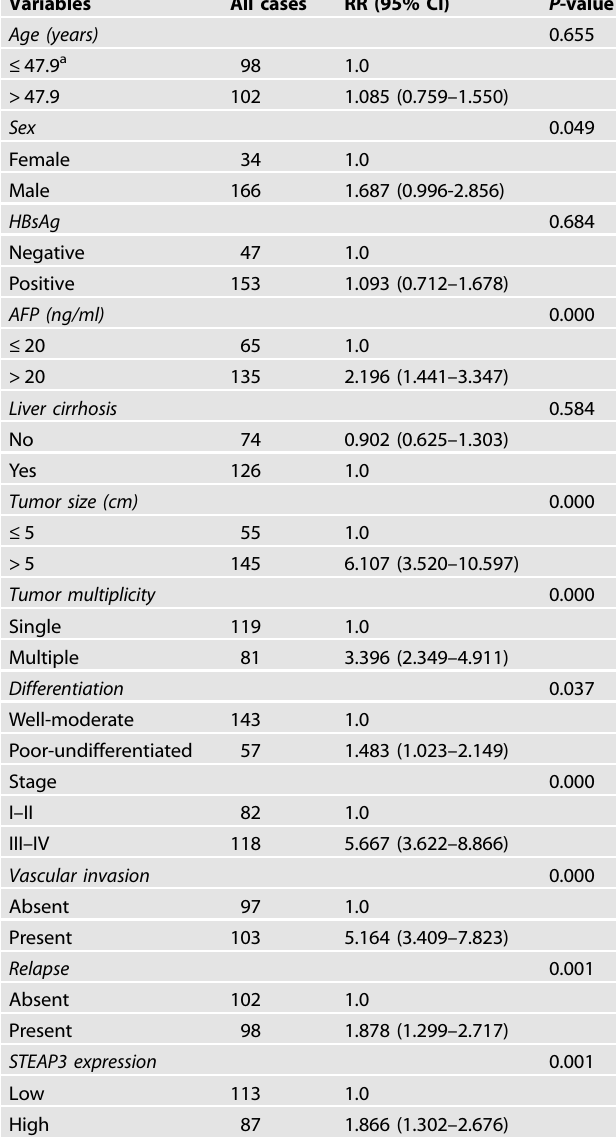
Table 2. Univariate analysis of nuclear expression of STEAP3 and clinicopathologic variables in 200 patients with primary hepatocellular carcinomas (log-rank test).